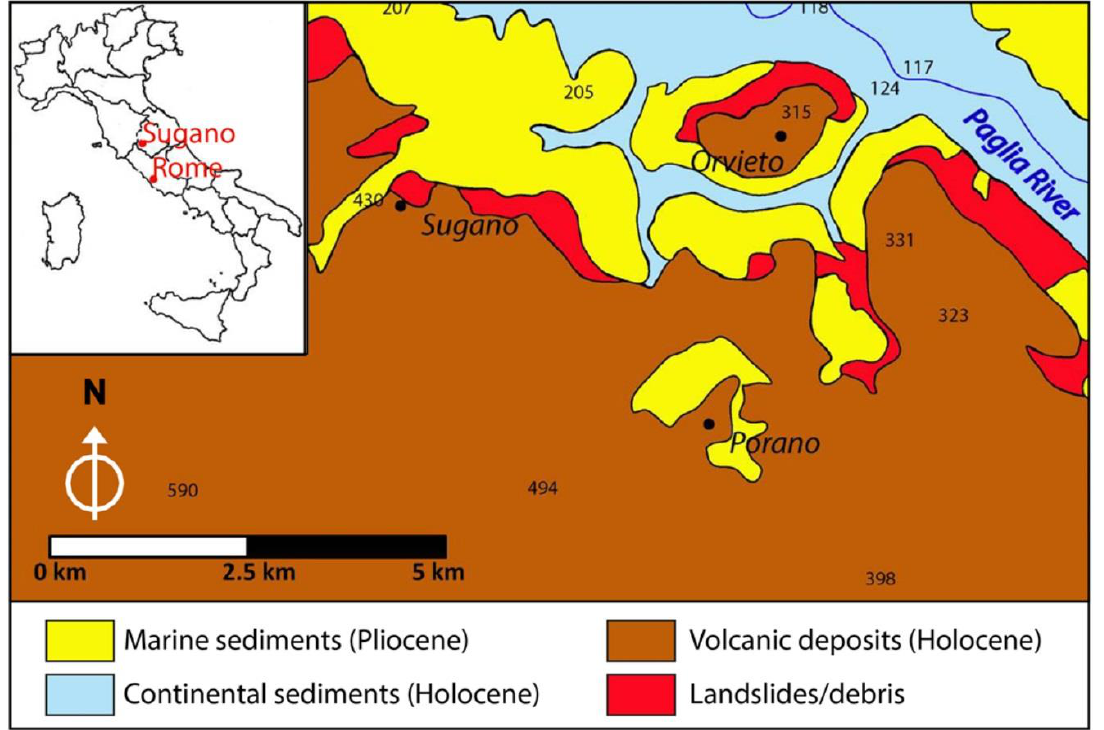
Figure 2. Geological sketch of the study area. Elevation (in m a.s.l.) is also reported for specific points.